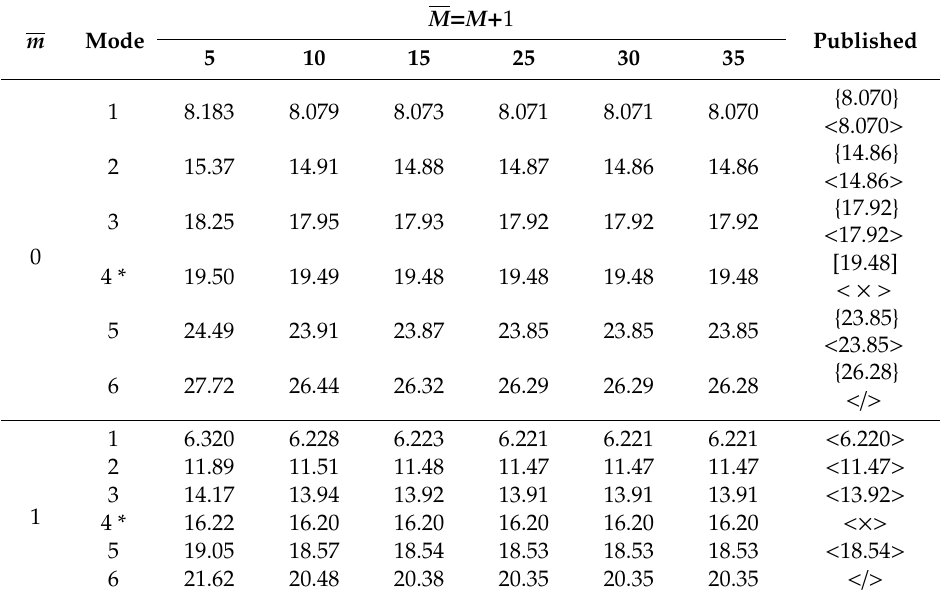
Table 3. Convergence of Ω for SCSC FGM square plates with h / b = 0.1.